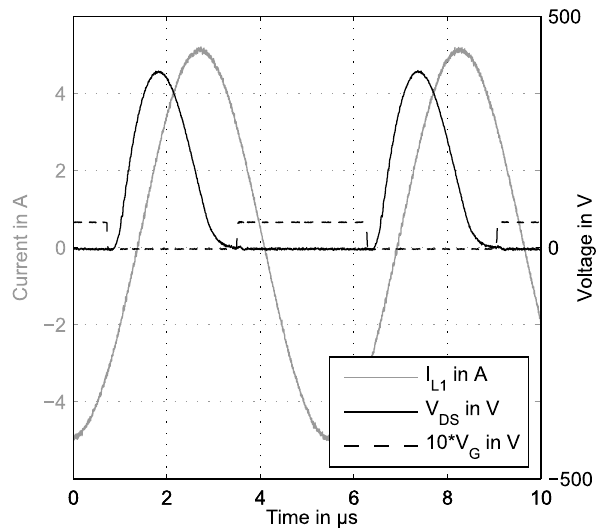
Figure 11. Measurement results for amplifier #2. Active power approx. 250W.